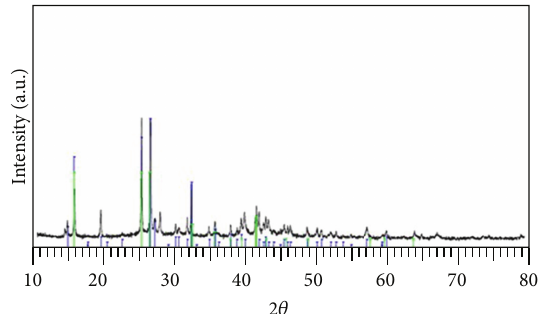
Figure 1: XRD pattern of composition [10%K 2 CO 3 + 90%H 3 BO 3 ], polycrystalline.